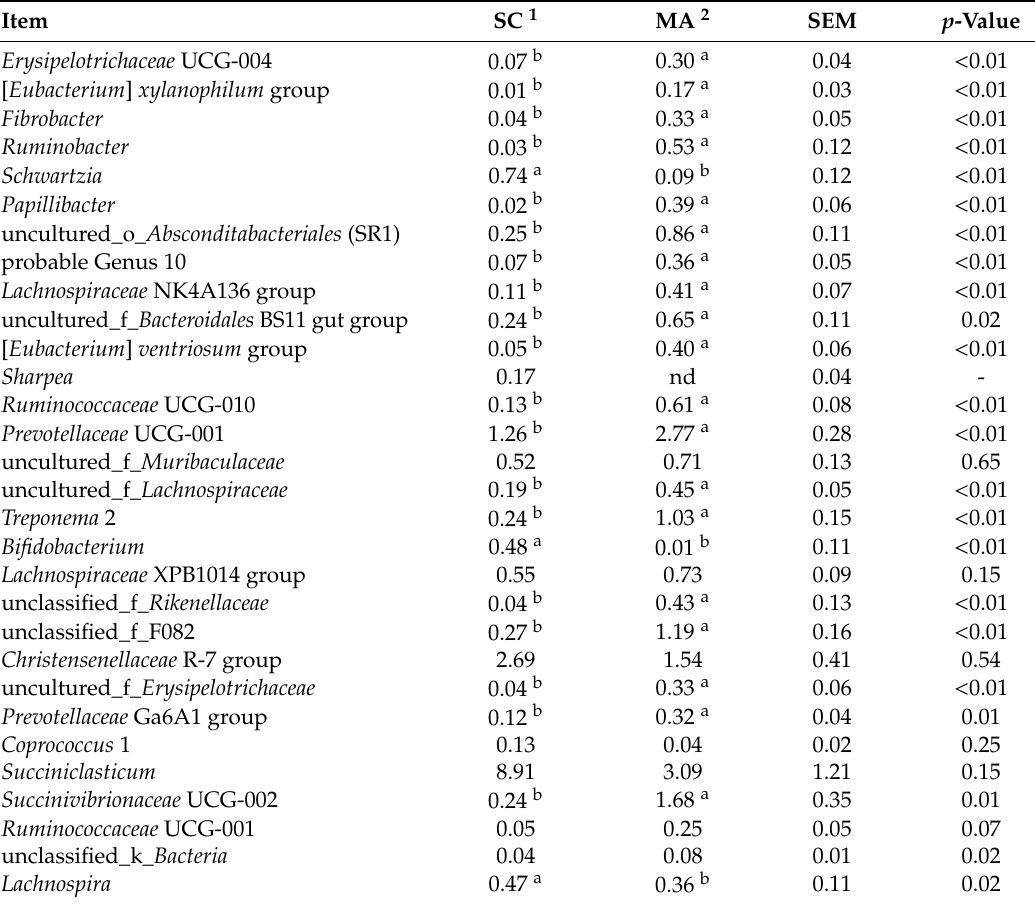
Table 3. Relative abundance of rumen bacteria with the top 30 mean decrease in accuracy between the two